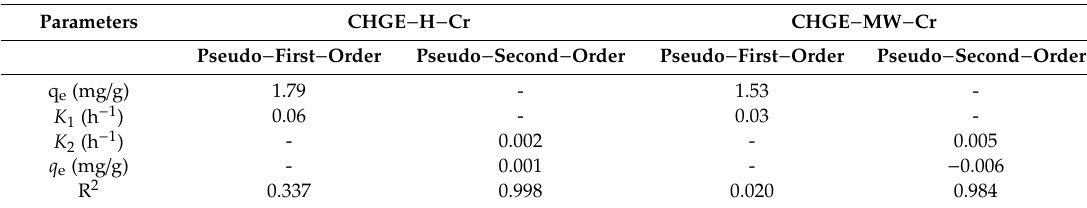
Table 6. Pseudo − second − order parameters for CHGE − H − Cr and CHGE − M − Cr.